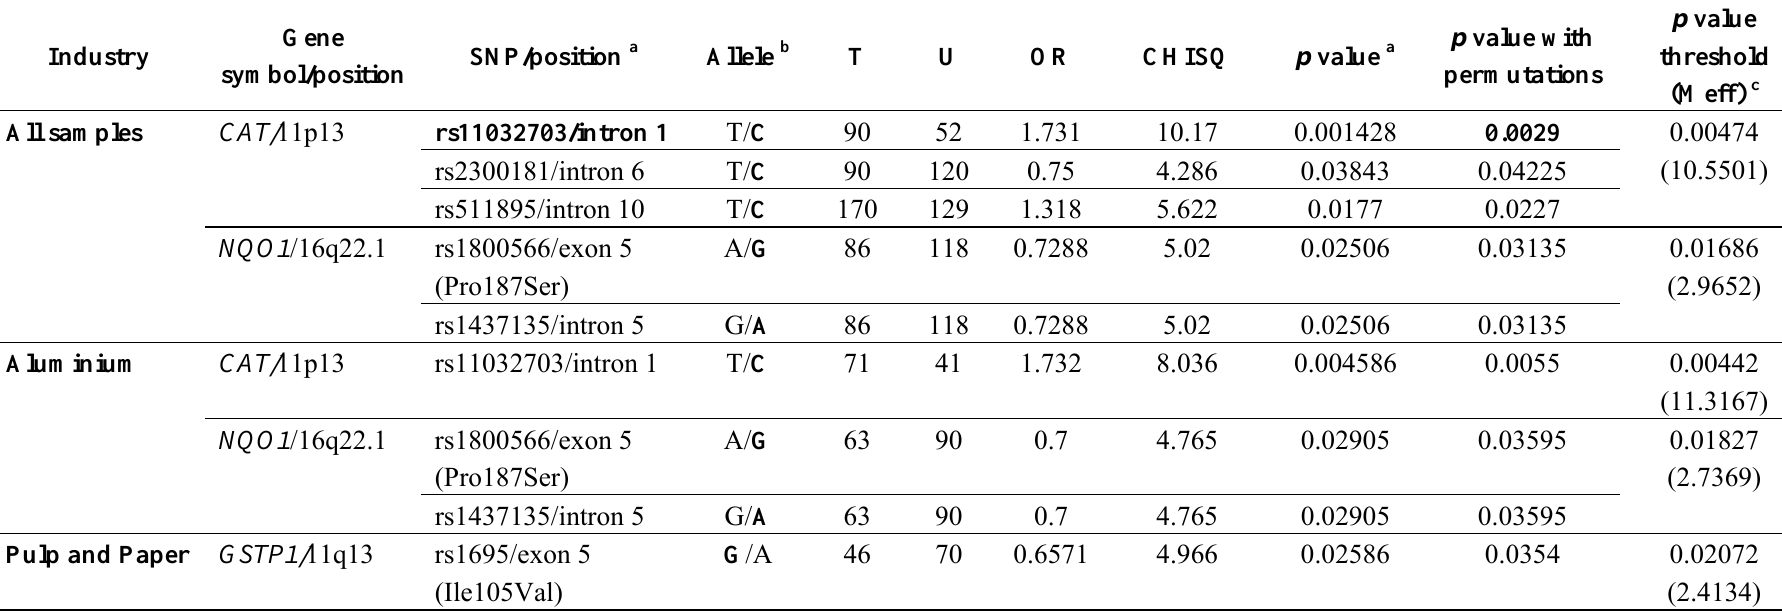
Table 3. Transmission disequilibrium test (TDT) results with p value < 0.05 for genes selected in the literature and stratified according to proximity to aluminium or pulp and paper